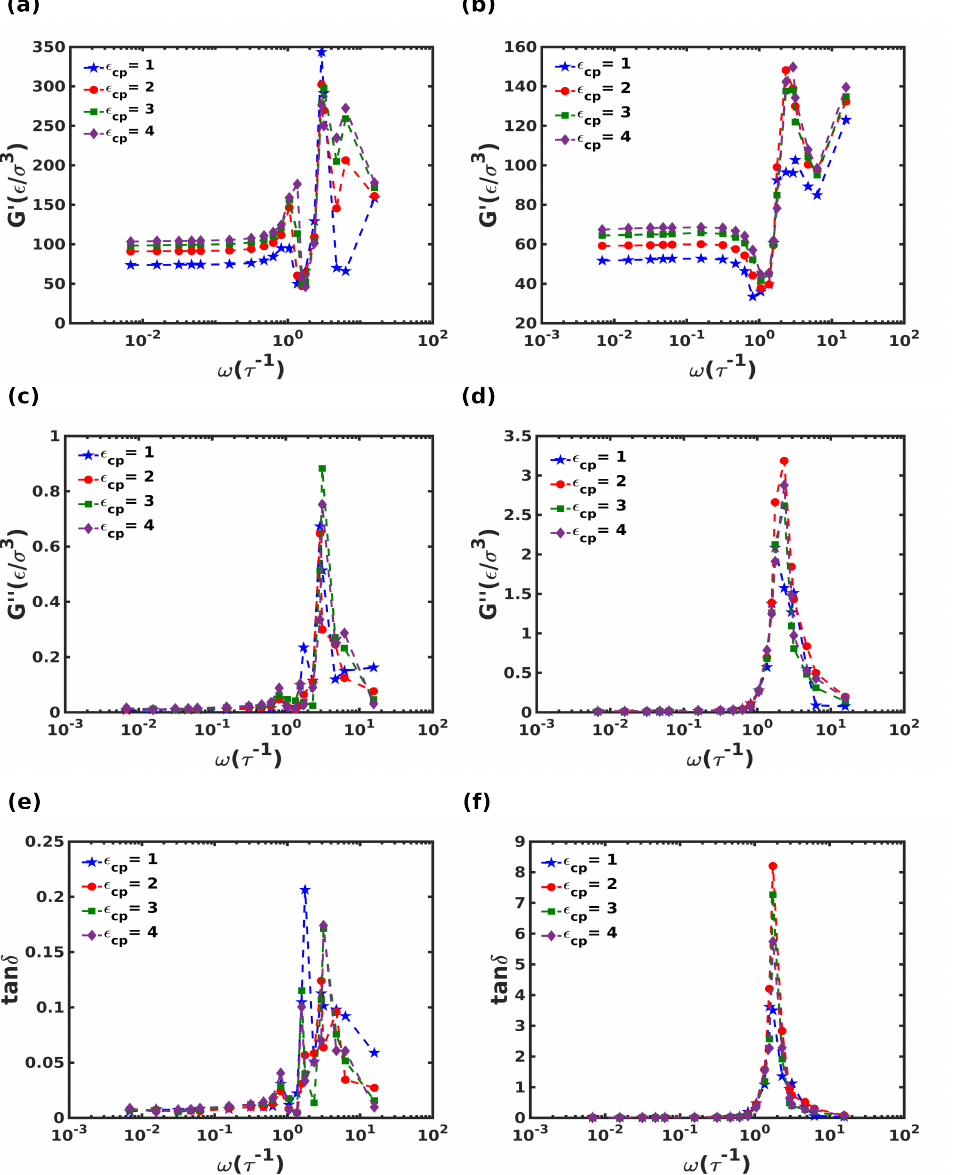
Figure 9. ( a , b ) Storage modulus ( G (cid:48) ), ( c , d ) loss modulus ( G (cid:48)(cid:48) ), and ( e , f ) tan δ for different polymer- crystal interactions, as a function of shear frequency for the columnar (panels ( a , c , e )) and the staggered (panels ( b , d , f )) composite